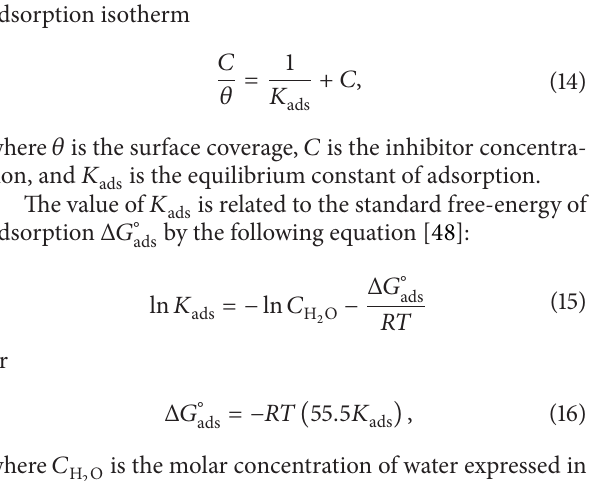
and Δ𝑆 ∘ for ads ads